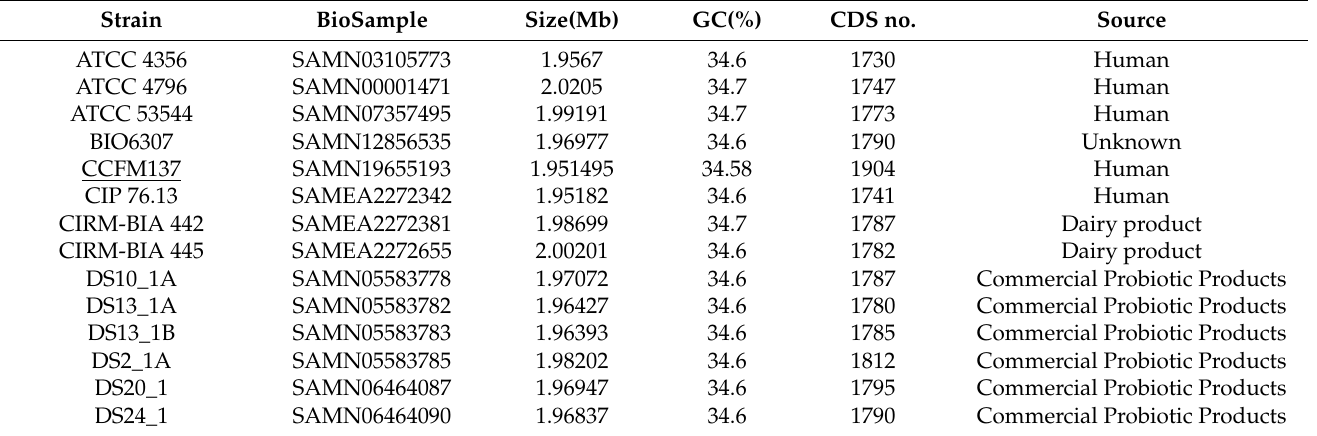
Table 1. Source information, BioSample and general genome features of 46 L. acidophilus strains.